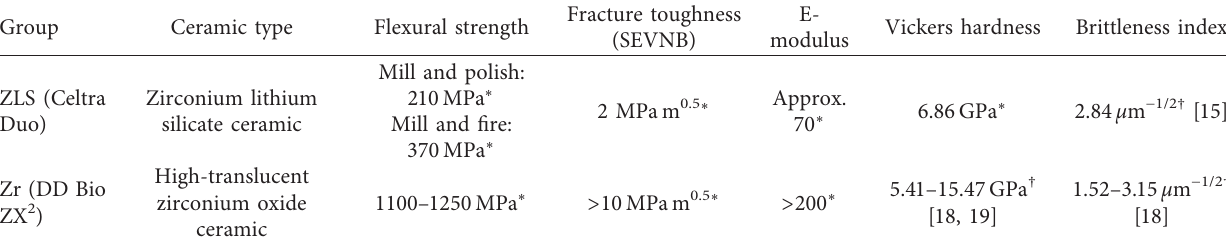
Table 1: The physical properties of ceramic materials used in the